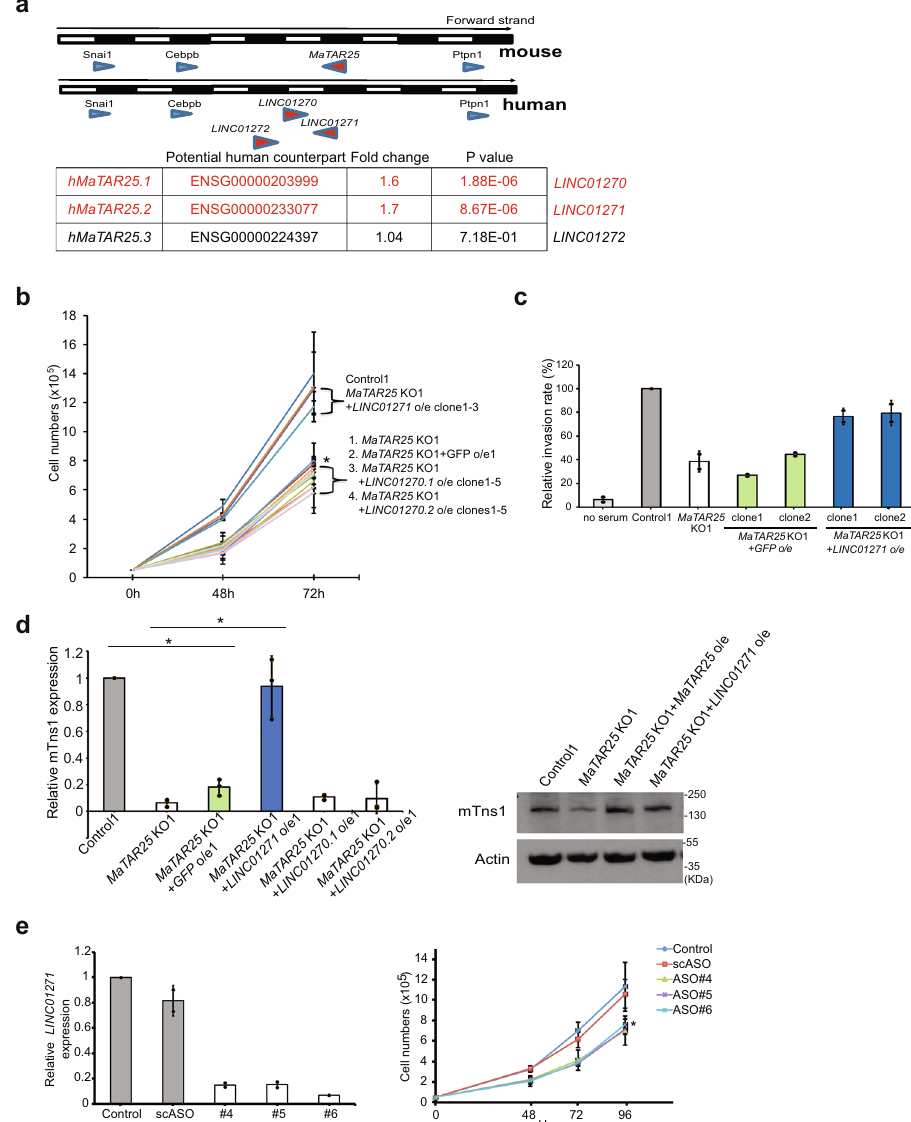
Fig. 6 Human LINC01271 is the human ortholog of MaTAR25 . a All potential human orthologs of MaTAR25 ( hMaTAR25 ) were identi fi ed based on conservation of genomic location (synteny). RNA-seq data from The Cancer Genome Atlas (TCGA) was analyzed to evaluate the expression status of all potential hMaTAR25 candidates by comparison of 1128 TCGA breast tumor datasets to 113 normal breast tissue controls. Fold change and statistical signi fi cance were calculated using the Wilcoxon rank test; P values were adjusted using the Benjamini & Hochberg method by DESeq2 30 . b Attempted rescue of 4T1 MaTAR25 KO cells upon ectopic expression of two transcript isoforms of LINC01270 ( LINC01270.1 , and LINC01270.2 ), or LINC01271 in cell viability assays. The mean cell numbers of three independent replicates of 4T1 control1, MaTAR25 KO1, MaTAR25 KO1 with GFP, LINC01270.1 clone1-5, LINC01270.2 clone1-5, and LINC01271 clone1-3 are shown ± SD ( n = 3) * P <0.05 (paired Student ’ s t test; two-tailed). c 4T1 MaTAR25 KO cells with ectopic expression of GFP was used as a control to assess rescue in a cell invasion assay. The mean relative cell invasion of two independent replicates of 4T1 control, MaTAR25 KO1, MaTAR25 KO1 with GFP clone1-2, LINC01271 ectopic expression clone1-2 is shown ± SD ( n = 2 independent experiments). Ectopic expression of LINC01271 can rescue the MaTAR25 KO cell invasion phenotype. d RNA expression level of Tns1 was determined in MaTAR25 KO1 cells ectopically expressing LINC01270.1 , LINC01270.2 , or LINC01271 by qRT-PCR. Data are presented as mean values±SD ( n = 3 independent experiments). * P <0.05 (paired Student ’ s t test; two-tailed). The protein level of mTns1 was also examined in MaTAR25 KO cells with ectopic expression of LINC01271 by immunoblot analysis. e Three different ASOs targeting LINC01271 were used to independently knockdown LINC01271 in MDA-MB-231 LM2 cells. Left panel: the knockdown ef fi ciency is calculated and data are shown as mean values±SD ( n = 2 independent experiments) by qRT-PCR after 24h treatment of ASOs. Right panel: the mean cell numbers of three independent cell counting experiments of MDA-MB-231 LM2 mock-treated control cells, cells treated with scrambled ASO, and cells treated with three different LINC01271 ASOs are shown ± SD ( n = 3). * P <0.05 (paired Student ’ s t test; proteins, we identi fi ed a speci fi c interaction between MaTAR25 and purine-rich element-binding protein B (PURB) which appears to be crucial for the downstream regulation of MaTAR25 .